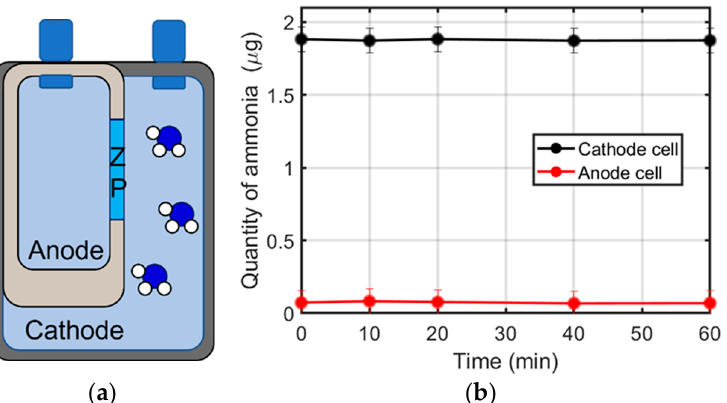
Figure 4. Scheme of the experimental setup: H-cell with Zirfon as separator and ammonia in the cathode compartment ( a ). Ammonia quantity in water solution in the two electrochemical chambers as a function of time ( b